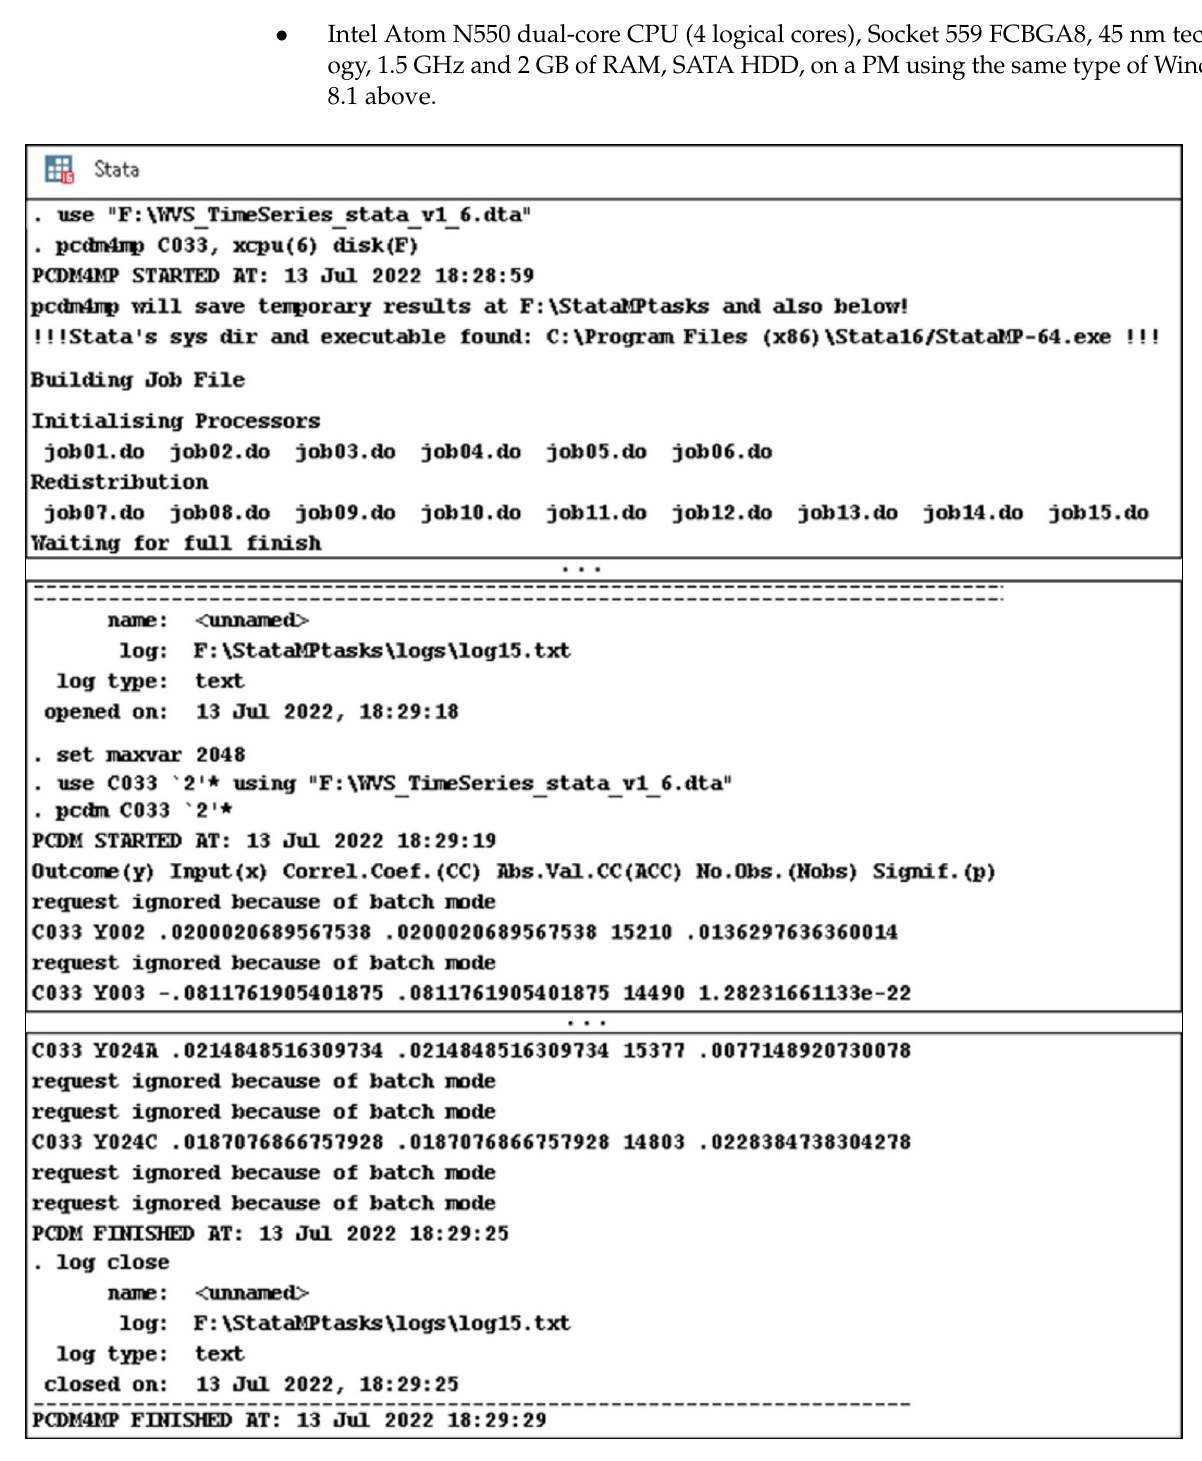
Figure 3. More advanced usage scenario involving its version for multi-processing (PCDM4MP) and six logical processing cores on the 2nd hardware configuration described in this paper (Table 1, 4th